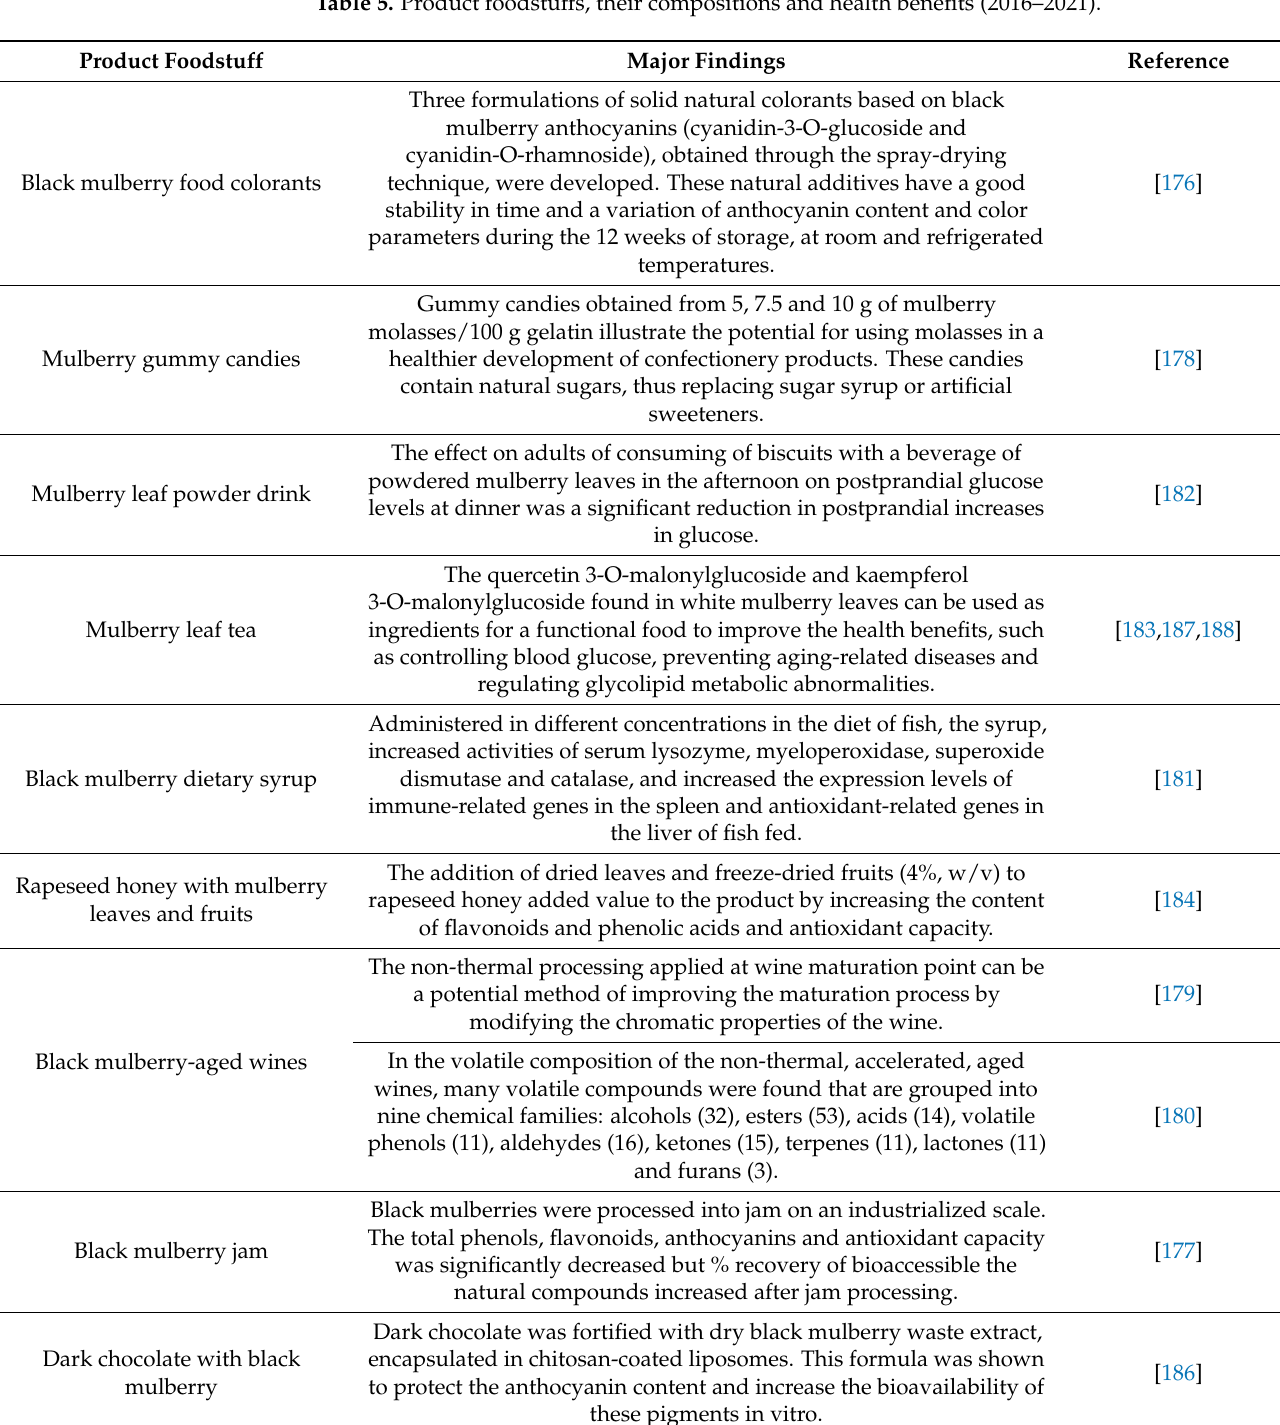
Table 5. Product foodstuffs, their compositions and health benefits